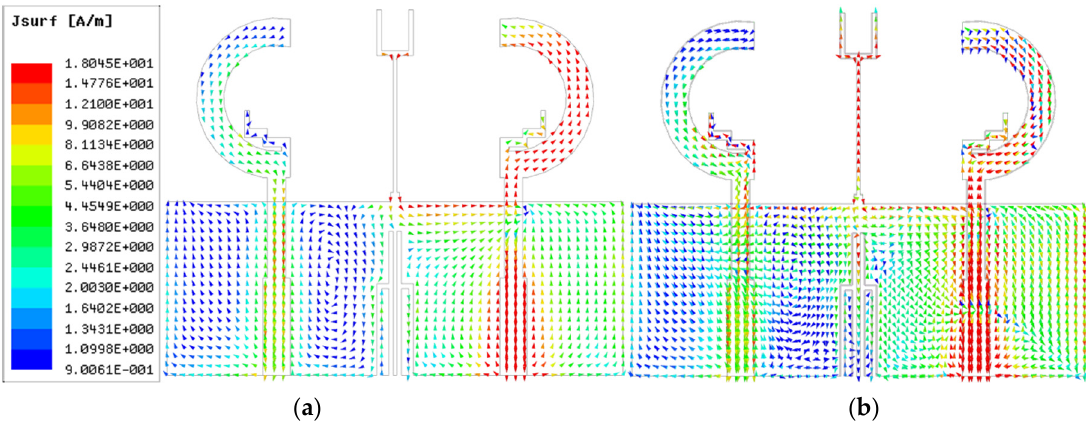
Figure 5. Simulated current distribution at two frequencies. ( a ) 2.4 GHz; ( b ) 5.5 GHz. The optimized antenna dimensions (in millimeters) are shown in Table